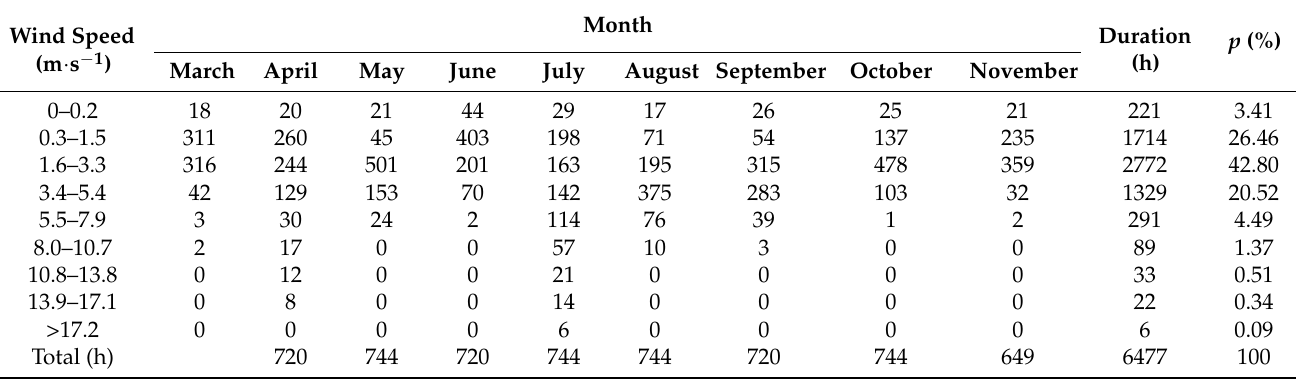
Table 6. Duration and frequency of wind speed at all levels during the non-freezing period.